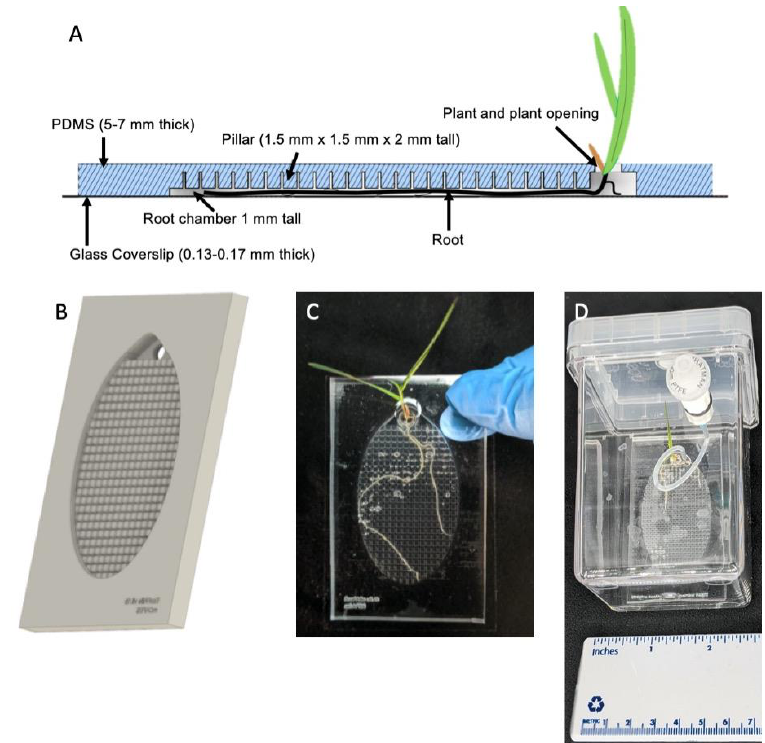
Figure 1. ( A ) Side-view of the Imaging EcoFAB device. The addition of pillars in the device allows media to flow easily through the device, while roots grow flat and against the coverslip. ( B ) Ren- dering of the PDMS component of the device. Shoots grow out of the top port. ( C ) Imaging EcoFAB with B. distachyon plant (20 days post germination, hydroponically grown in 0.1 MS). ( D ) Imaging EcoFAB in sterile housing with B. distachyon plant (14 days postgermination, hydroponically grown in 0.1